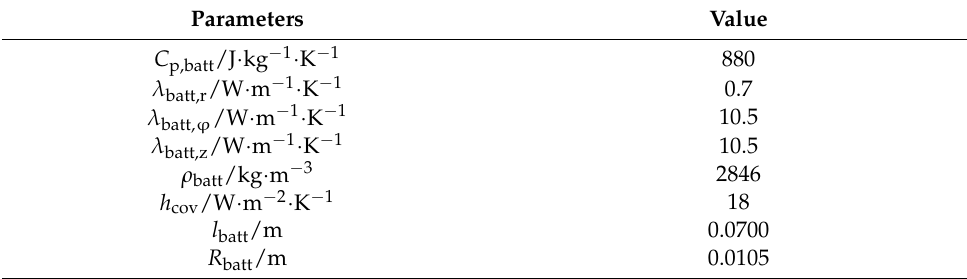
Table 3. Parameters used in the thermal